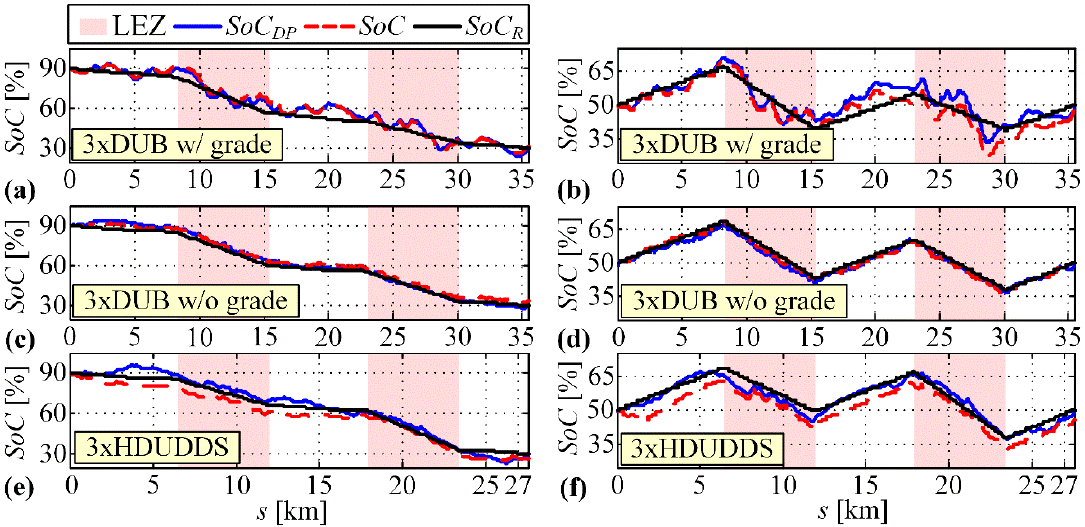
Figure 15. DP optimal, simulated and reference SoC trajectories for case of LEZ presence, ( a , b ) 3xDUB w/ grade, ( c , d ) 3xDUB w/o grade and ( e , f ) 3xHDUDDS driving cycles and different sets of initial and final SoC values (( a , c , e ) SoC i = 90%, SoC f = 30%, left column and ( b , d , f ) SoC i = 50%, SoC f = 50%, right column). Table 1. Fuel consumption values corresponding to simulation results from Figure 15 and their relative differences in comparison with DP benchmark (given in brackets).